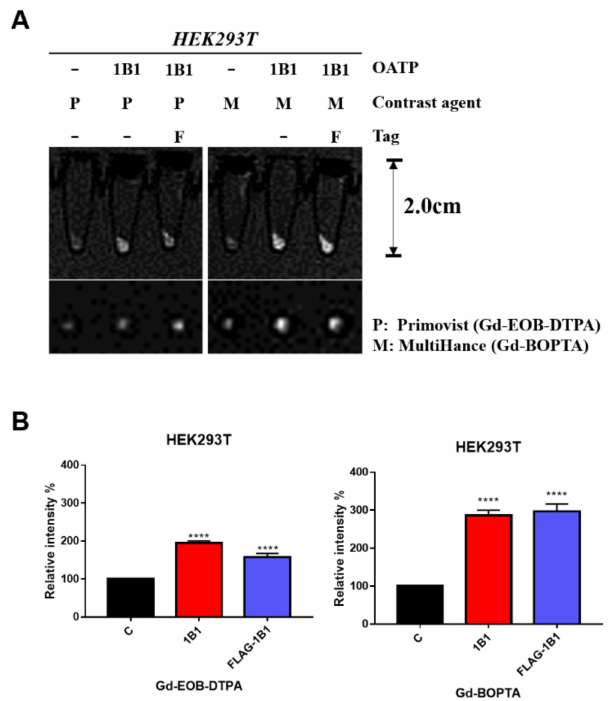
Figure 2. In vitro MRI contrast agent uptake in 293T cells. ( A ) OATP-expressing and untransfected 293T cells were treated with MRI contrast agents. After washing with PBS three times, the cells were scanned with a 1.5-T MRI system. ( B ) The quantitative signal intensity of cell MRI ( n = 3). Error bars show the standard error and mean, and **** represents results with p < 0.0001. C, control; 1B1, OATP1B1-expressing cells; F, OATP1B1 fused with FLAG tag; P, Primovist (Gd-EOB-DTPA); M, MultiHance